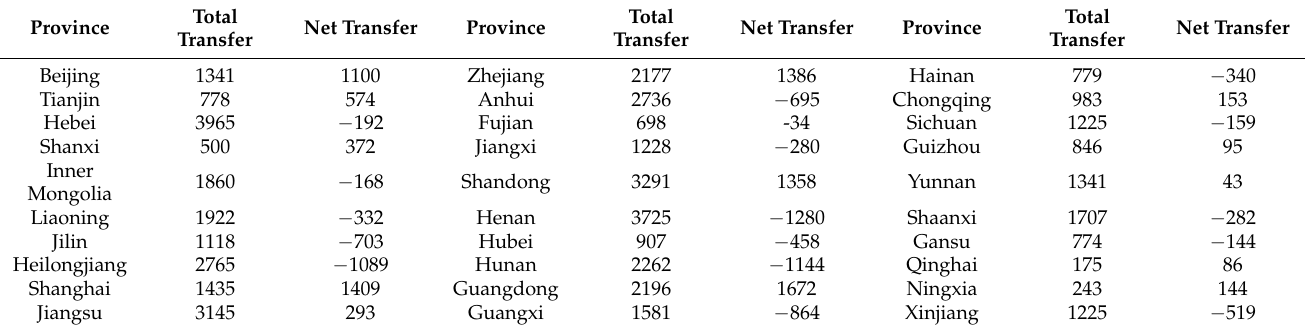
Table 6. Amount of embodied agricultural land transfer (10 4